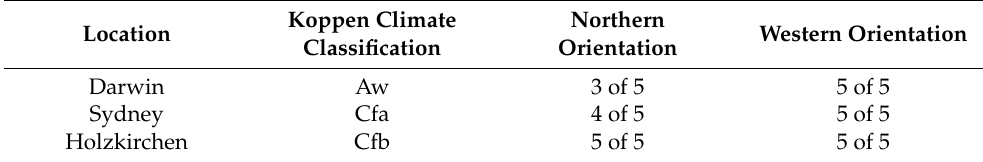
Table 6. Ratio of bio-hygrothermal Mould Index results that changed when a multipoint water vapour diffusion resistance was